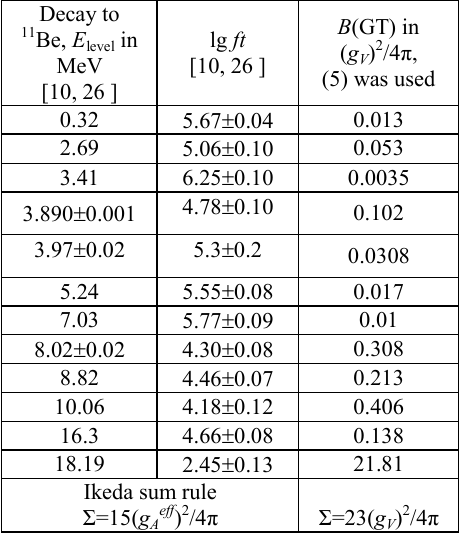
Fig. 3. Structure of the β-decay strength function for 11 Li GT β - -decay in g V 2 /4π units.